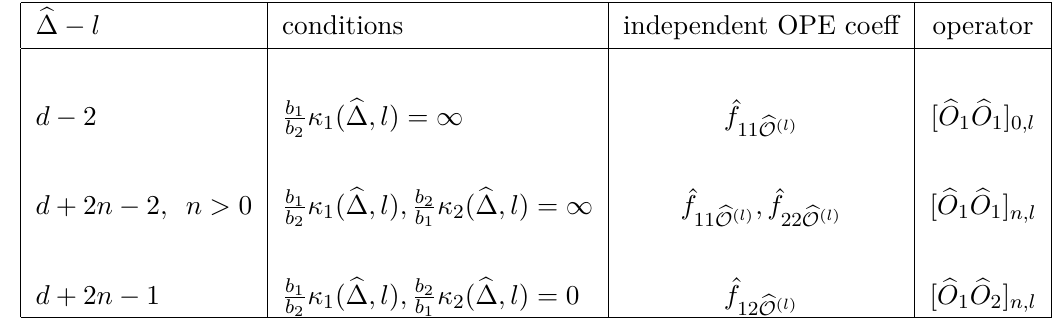
Table 1. Table of special multiplets and their selection rules. Recall that b 2 b 2 = ( d − 2) (1 − 2 d − 2 a 2